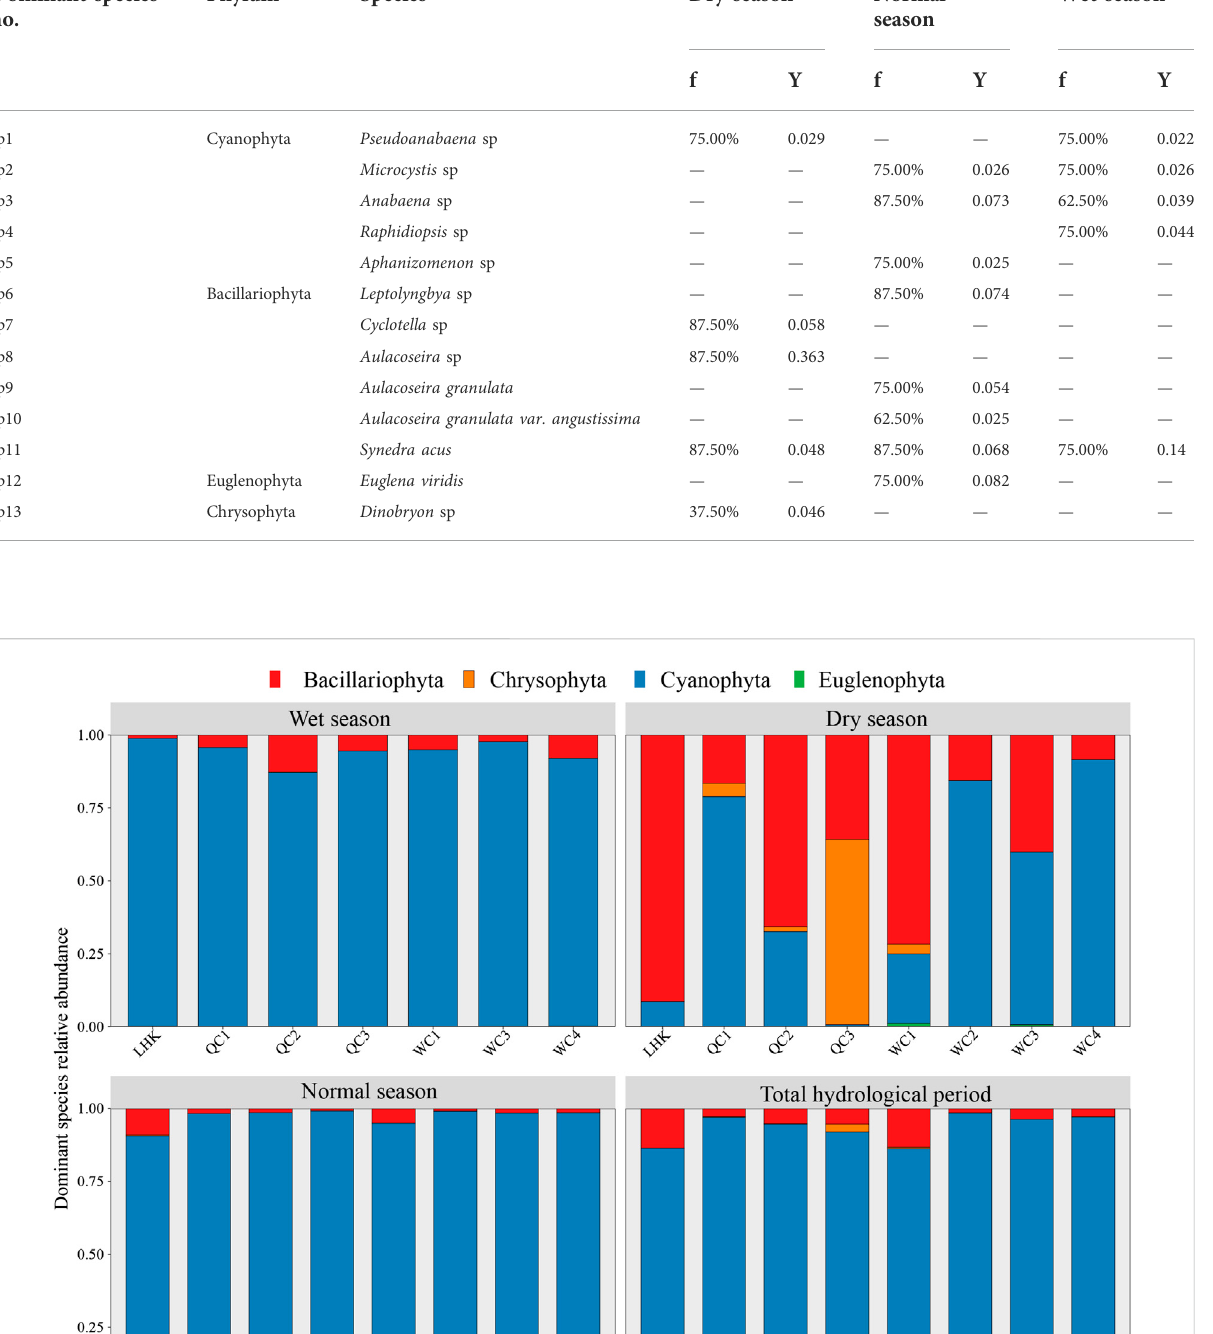
TABLE 2 Occurrence frequency (f) and dominance (Y) of the dominant phytoplankton species. Dominant species no.